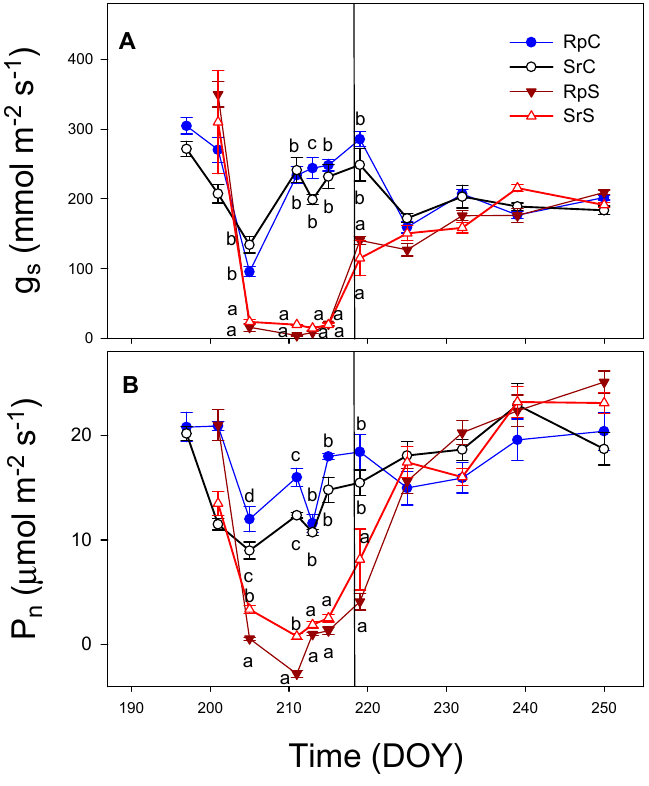
Figure 5. Evolution of stomatal conductance (g s , ( A )) and net photosynthesis rate (P n , ( B )) in P. dulcis plants submitted to different treatments. Values are means + s.e., n = 6. Symbols represent the different treatments: RpC (filled circles; plants grafted under full irrigation), SrC (open circles; self-rooted plants under full irrigation), RpS (filled triangles; plants grafted submitted to water stress) and SrS (open triangles; self-rooted plants submitted to water stress). Different lowercase letters indicate significant differences between treatments according to Duncan 0.05 test. Vertical line indicates irrigation change, the end of the water stress period and the beginning of recovery period.